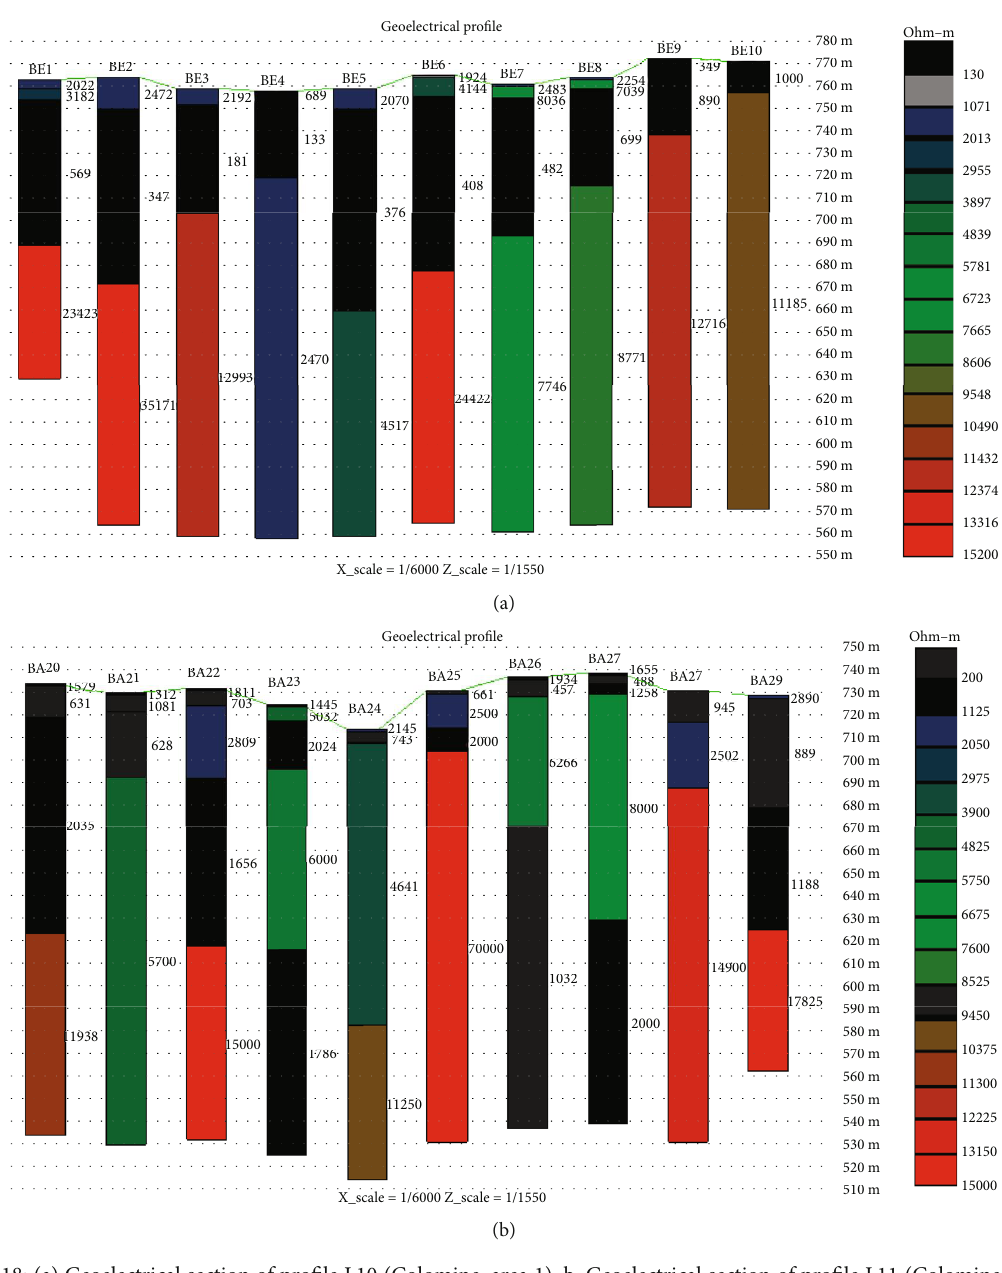
Figure 18: (a) Geoelectrical section of pro fi le L10 (Colomine, area 1). b. Geoelectrical section of pro fi le L11 (Colomine, area